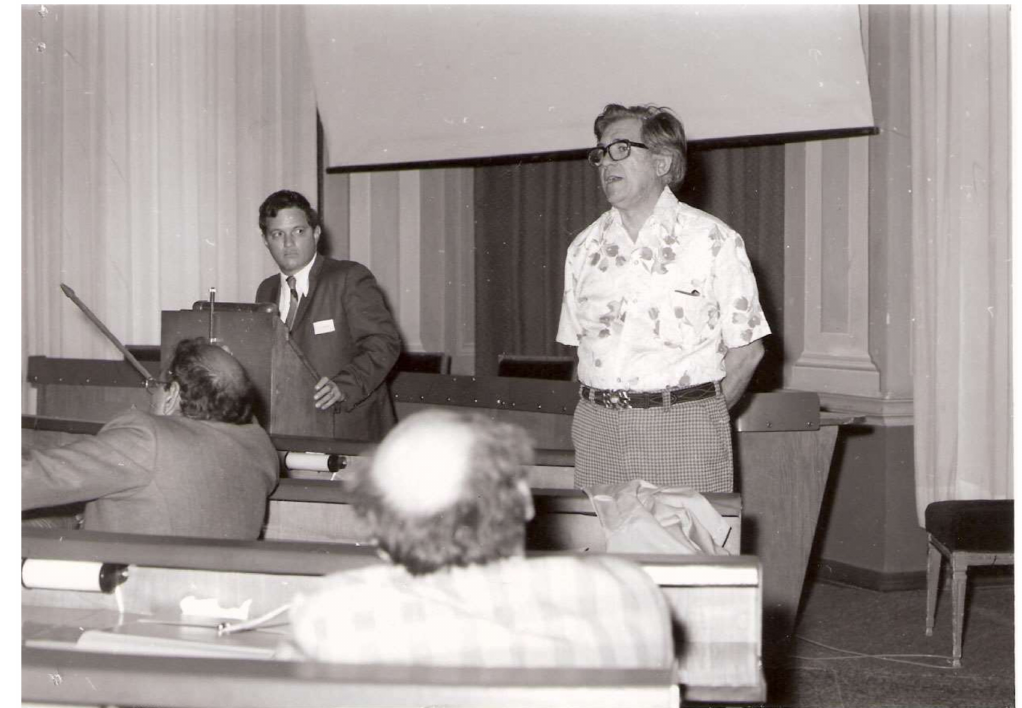
Figure 1. In 1976, Orson gave one of the invited talks at a workshop on seismic anisotropy in the Castle of Liblice in Czechoslovakia, convened by Vladislav Babuska, Jaroslava Plomerova, and